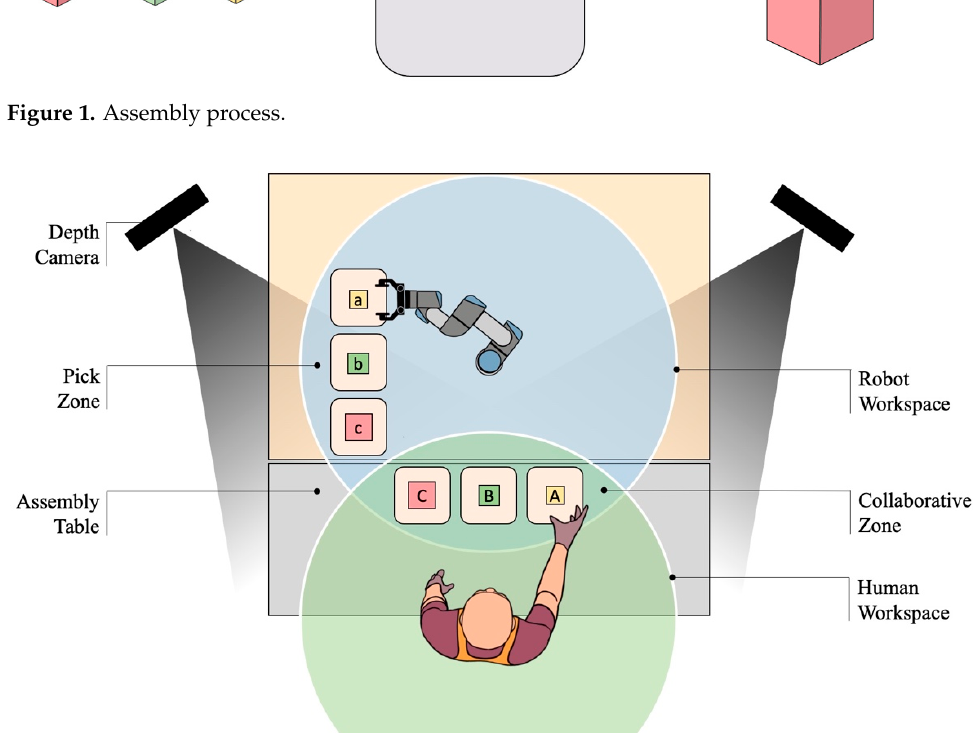
Figure 2. Collaborative assembly cell.